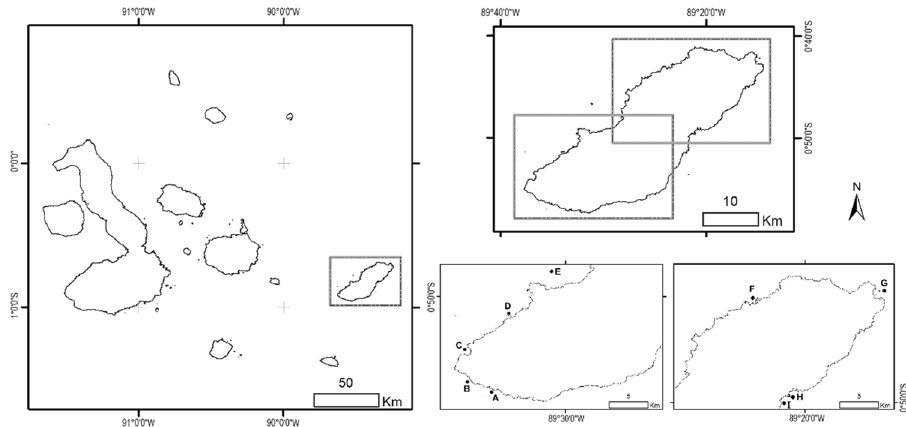
Figure 1. Study area showing the sampling sites (black dots) on the shelf of San Cristóbal Island in the southeastern Galapagos archipelago. (A) Las Negritas (0° 56 ′ 29.874 ″ S, 89° 35 ′ 07.84 ″ W), (B) La Lobería (0° 55 ′ 47.25 ″ S, 89° 36 ′ 45.65 ″ W), (C) Karahua (0° 53 ′ 43.34 ″ S, 89° 37 ′ 23.38 ″ W), (D) Isla Lobos (0° 51 ′ 23.01 ″ S, 89° 33 ′ 55.49 ″ W), (E) León Dormido (0° 46 ′ 42.51 ″ S, 89° 31 ′ 13.12 ″ W), (F) La Tortuga (0° 43 ′ 8.28 ″ S, 89° 23 ′ 29.99 ″ W), (G) Punta Pitt (0° 41 ′ 58.99 ″ S, 89° 14 ′ 42.24 ″ W), (H) Rosa Blanca-Coral (0° 49 ′ 43.60 ″ S, 89° 21 ′ 14.25 ″ W) and (I) Rosa Blanca-Mangrove (0° 49 ′ 51.25 ″ S, 89° 21 ′ 41.79 ″ W). The map was created using ArcGIS 10.5.1 (ESRI, https:// www. esri.